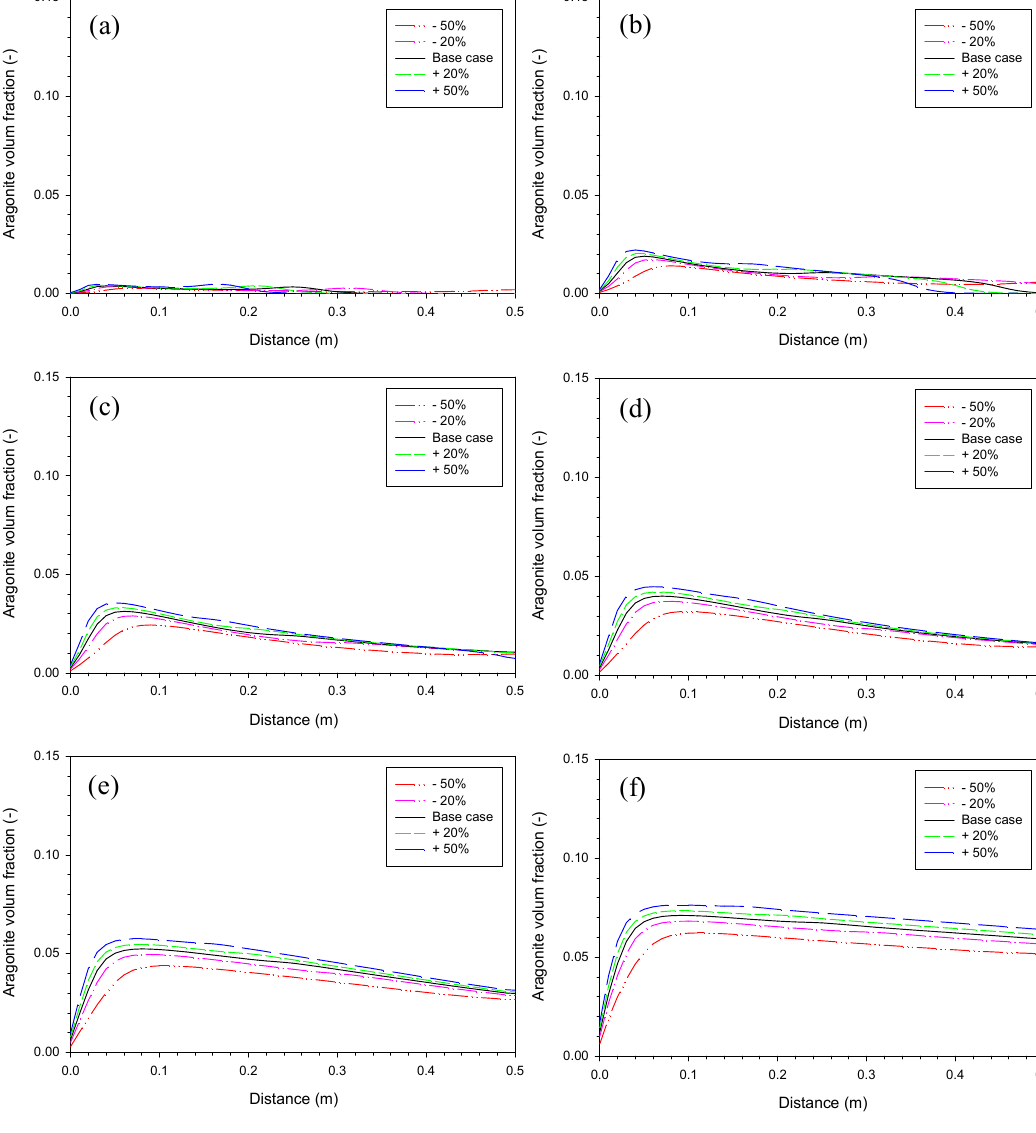
Figure 2. Sensitivity analysis of iron corrosion rate. Aragonite volume fraction on ( a ) Day 4, ( b ) Day 25, ( c ) Day 54, ( d ) Day 87, ( e ) Day 164, and ( f ) Day 410 with value of the base case, +/−20% and +/−50%.